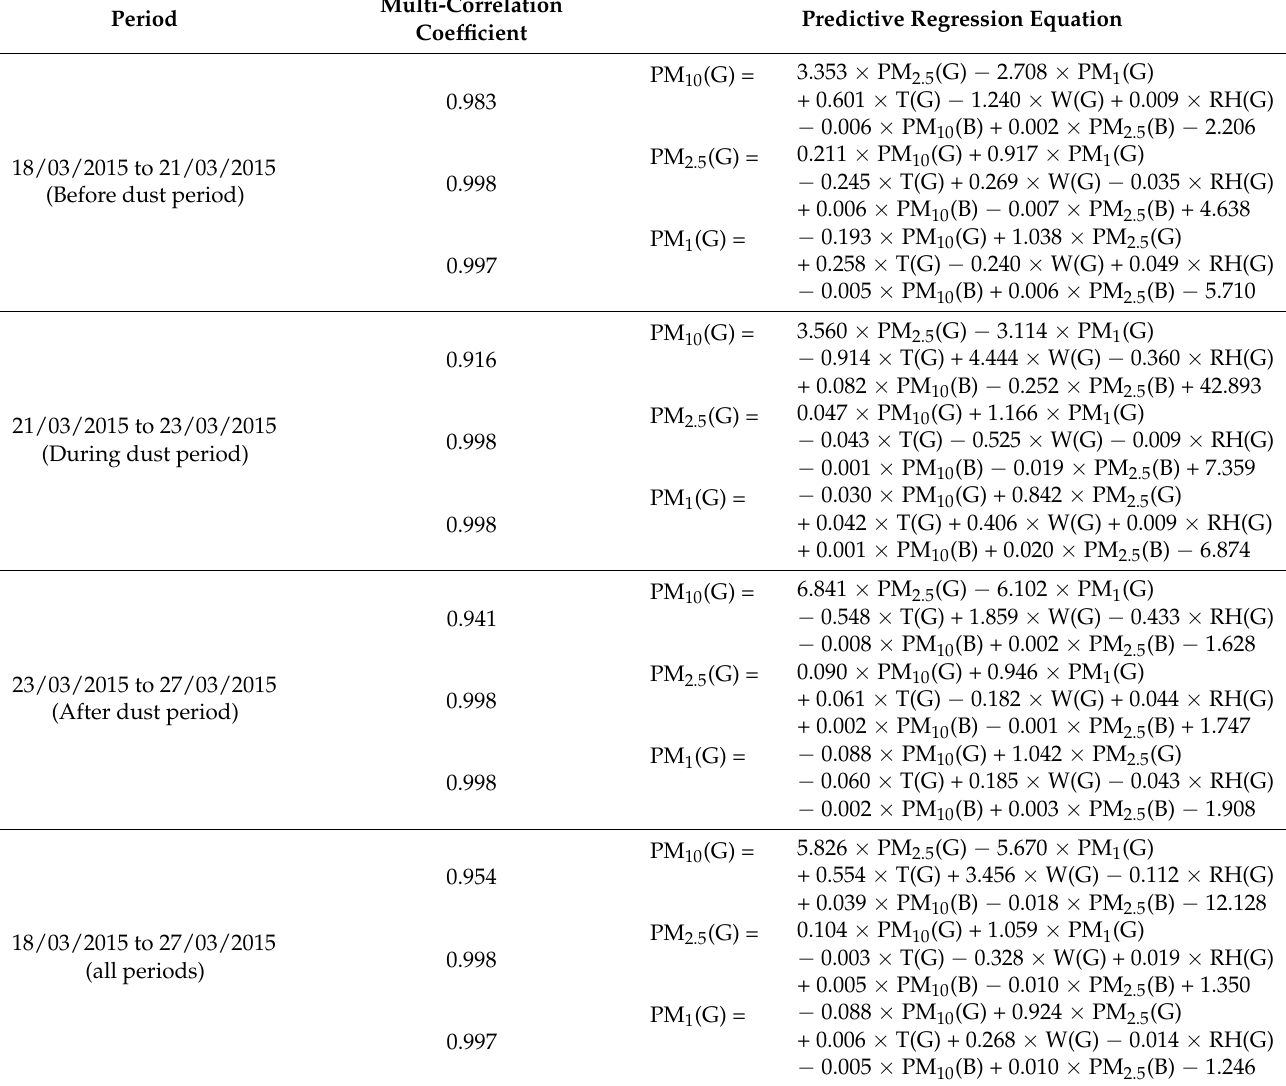
Table 1. Multiple correlation coefficients and predictive regression equations among PMs of Gangneung city (G) with PMs of Beijing city (B) under the influence of meteorological parameters. T, W and RH denote air temperature ( ◦ C), wind speed (m/s) and relative humidity